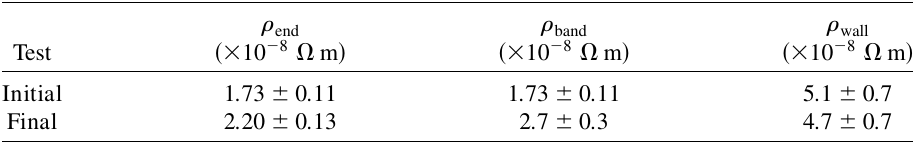
TABLE XI. Electrical resistivities of the end caps and cavity sidewall before and after the indicates the resistivity along the end cap assuming the entire second high-power test. (cid:16) end indicates the resistivity in a band approximately 7 to 8 mm in width surface changed. (cid:16) band around the area of maximum temperature rise assuming there is no damage outside the